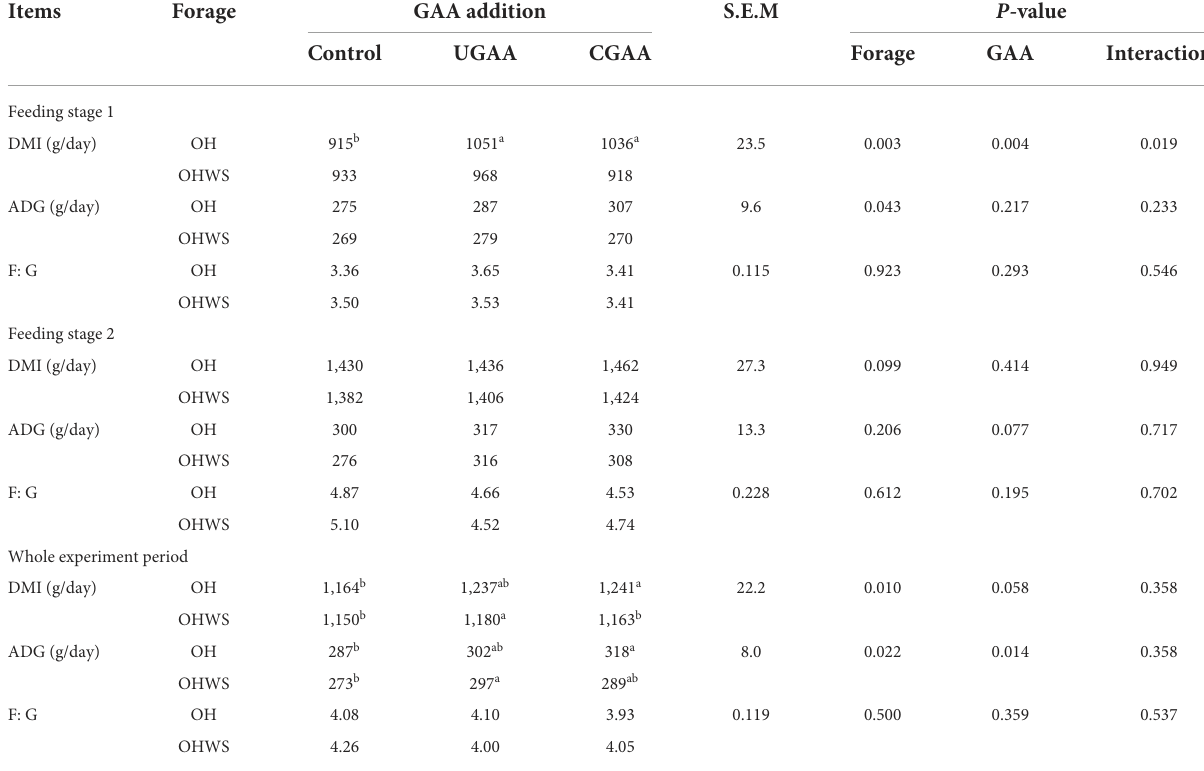
Forage GAA Interaction